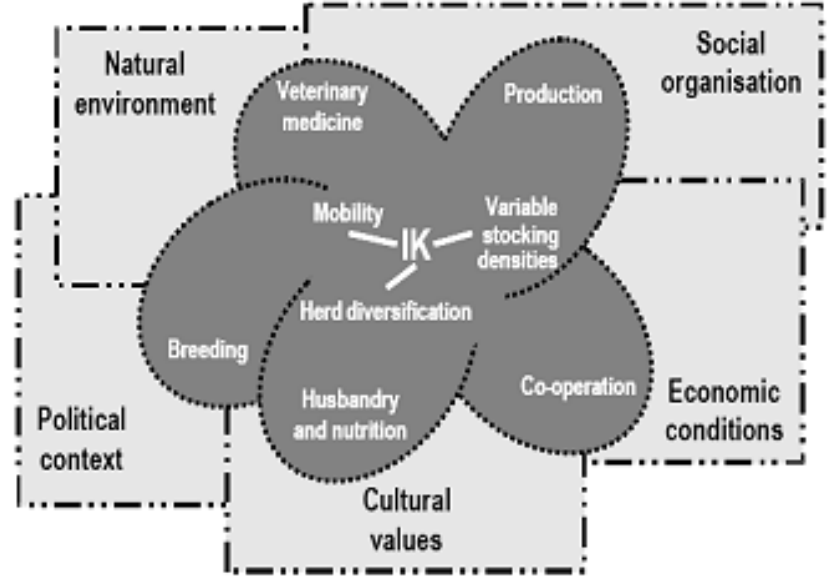
Figure 1. Model of pastoralists’ knowledge in opportunistic range management (Adapted from Sandford,